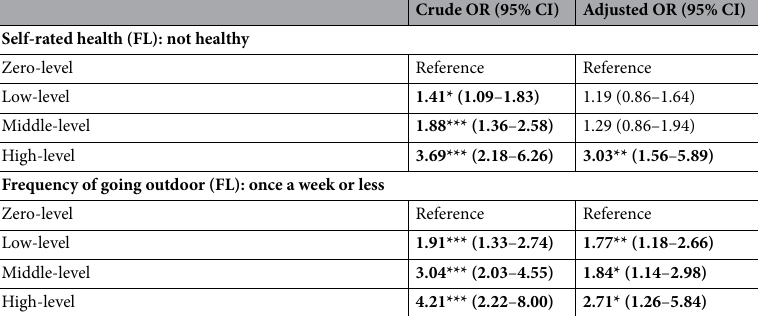
Crude OR (95% CI) Adjusted OR (95%